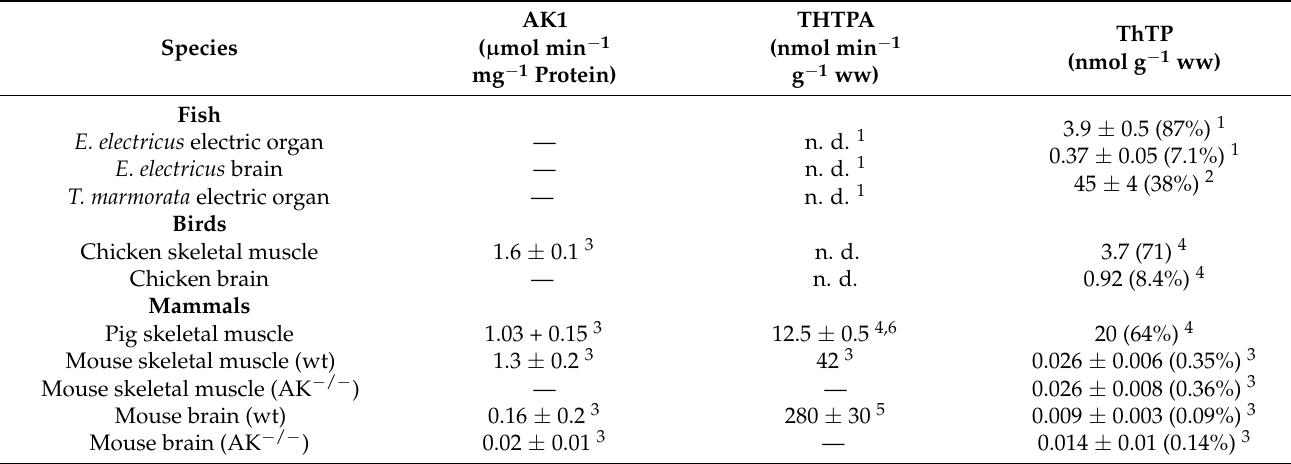
Table 1. Relative ThTP content and AK1 and THTPA activities in various animal species. This table shows a correlation between, on the one hand, ThTP levels and, on the other hand, low ThTPA activity and high AK1 activity.